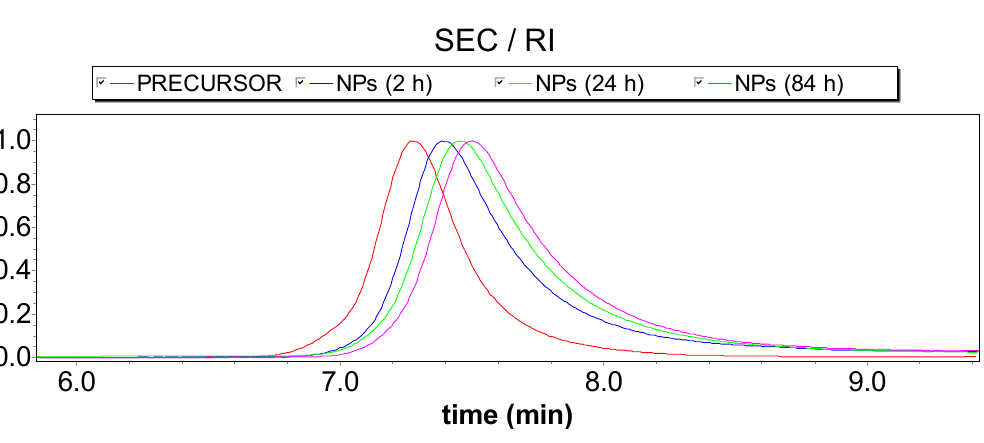
Figure 3. Evolution of the size-exclusion chromatography (SEC) traces with reaction time during the synthesis of PMMA-NPs by enamine “click” chemistry from precursor 1a . All curves from the SEC/refractive index (RI) detector are normalized to the same ordinate scale for clarity of